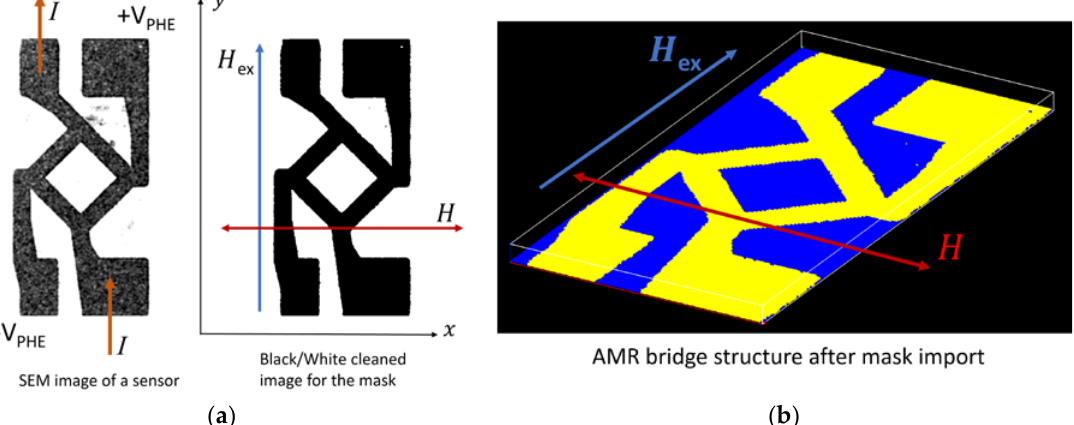
Figure 6. AMR bridge sensor, multi-domain simulation mask layout: ( a ) SEM image of the sensor with obtained mask image after editing; ( b ) Overview of the imported mask in the software with the marked direction of the applied field and exchange bias field.